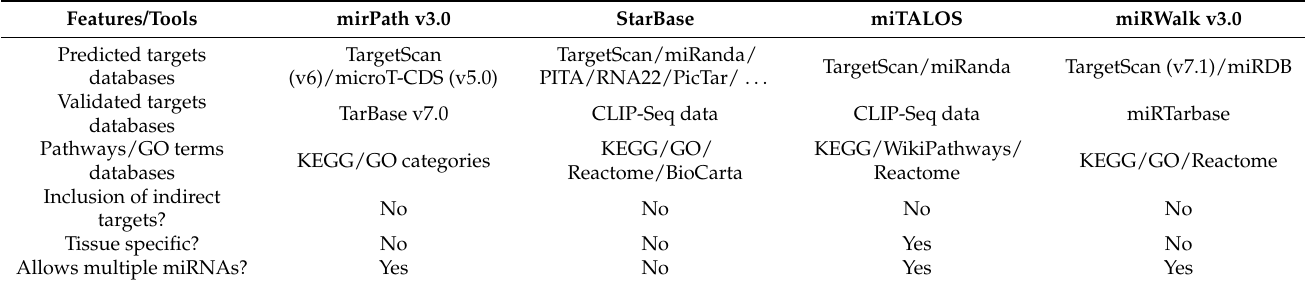
Table 1. A comparison of the widely used tools of miRNAs pathway analysis.